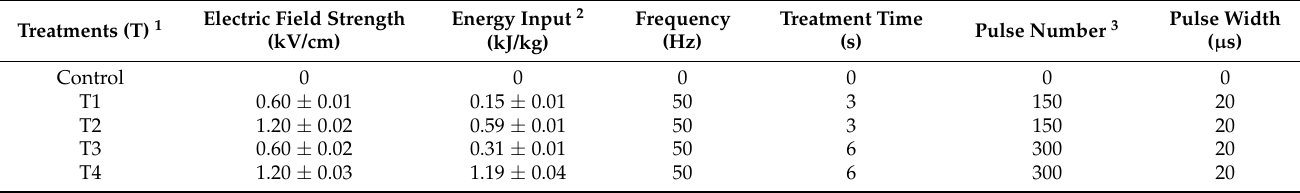
Table 1. Pulsed electric field treatment parameters applied in experiment 1. Electric field strength and total specific energy input values are expressed as means ± standard